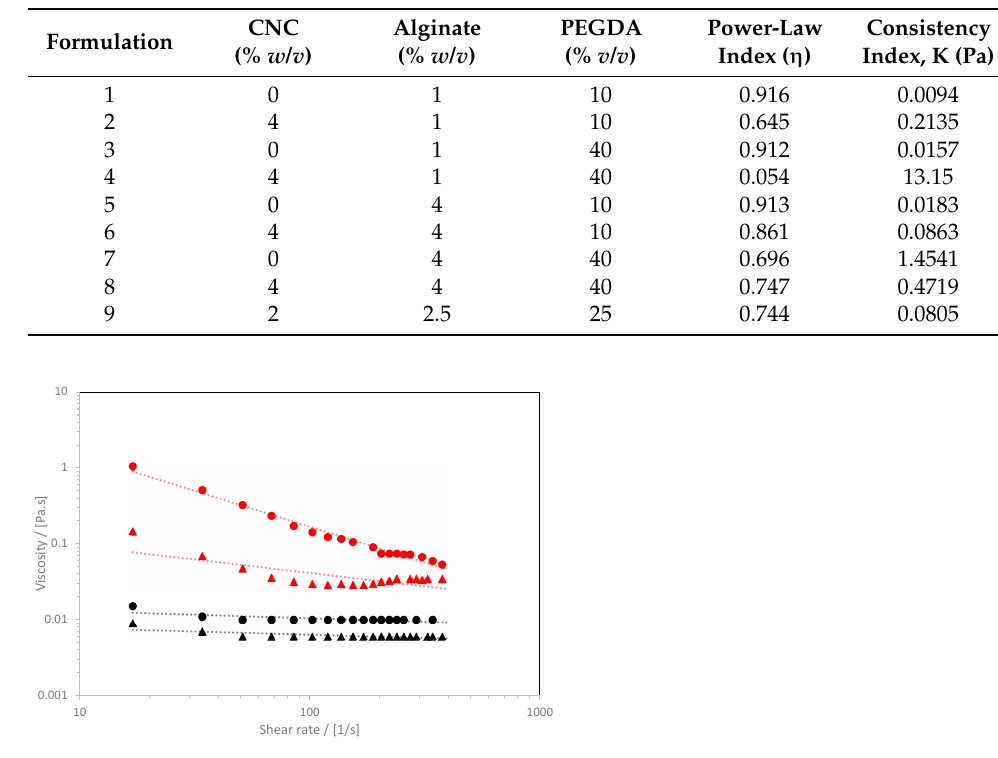
Figure 5. Flow curves of four different CNC/Alg/PEGDA pre-gel formulations indicating shear- thinning properties: ( ) F4: [4% CNC: 1% Alg: 40% PEGDA]; ( ) F2: [4% CNC: 1% Alg: 10% PEGDA]; ( ) F3: [1% Alg: 40% PEGDA]; and ( ) F1: [1% Alg: 10% PEGDA]. Data points represent actual data, and lines are power-law model fits.